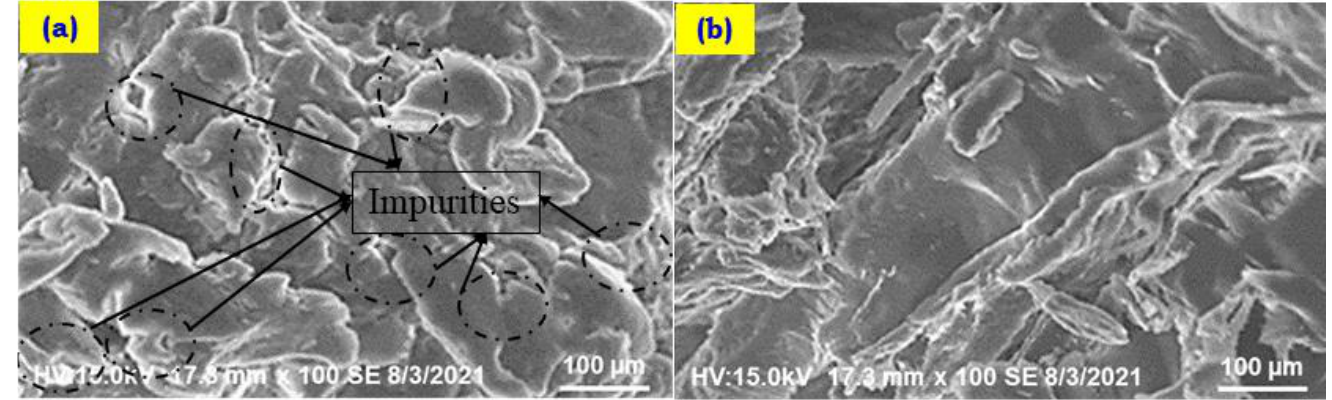
Figure 1. SEM micrograph of pineapple leaf fiber ( a ) without silane treatment and ( b ) with silane treatment.